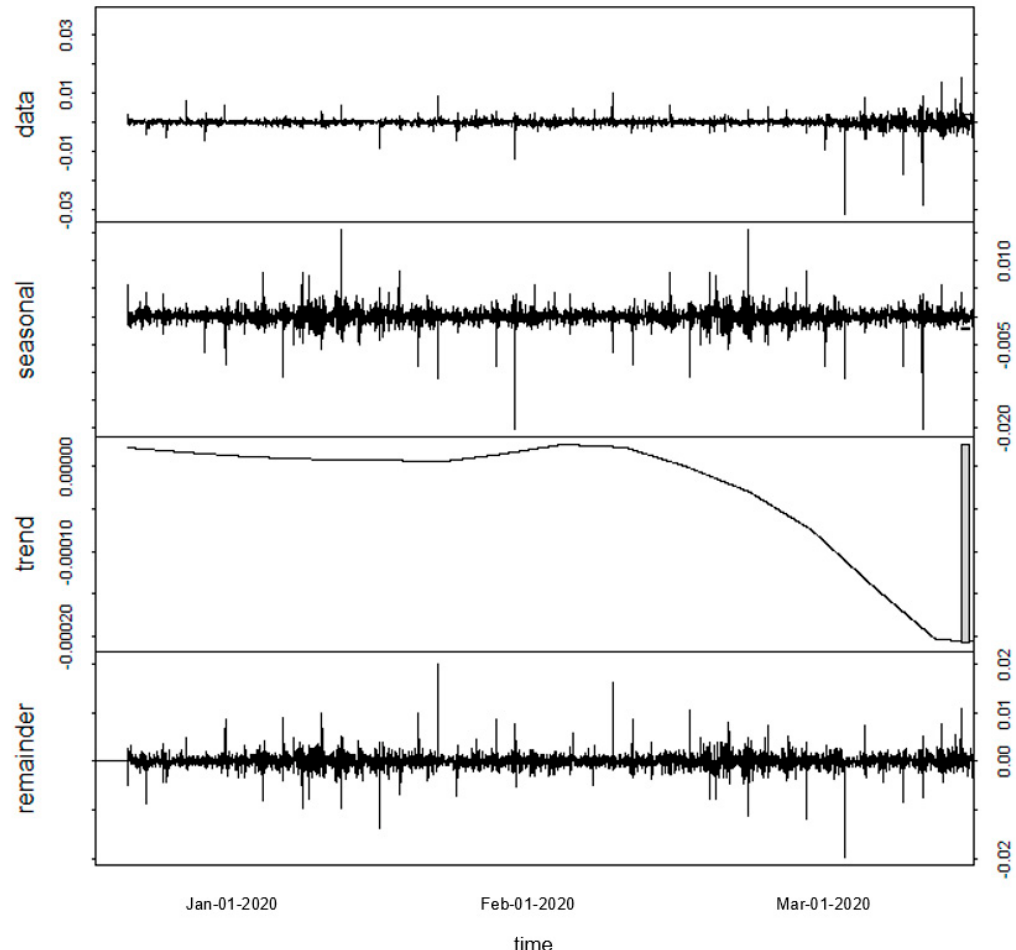
Figure 2. Seasonal and Trend decomposition using Loess (STL) of Italian stock index (FTMIB) returns, (1st row) original five-minute time series, (2nd row) seasonal component, (3rd row) trend component, (4th row) remainder.